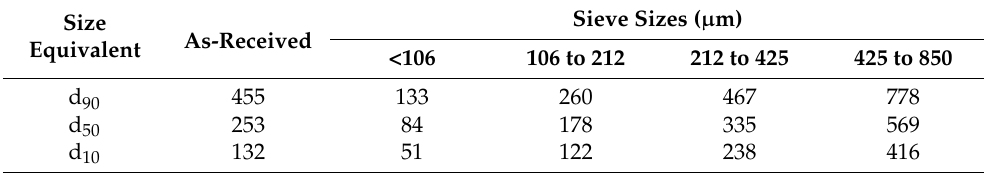
Table 1. D 90 , d 50 , and d 10 ( µ m) of as-received and size-fractioned